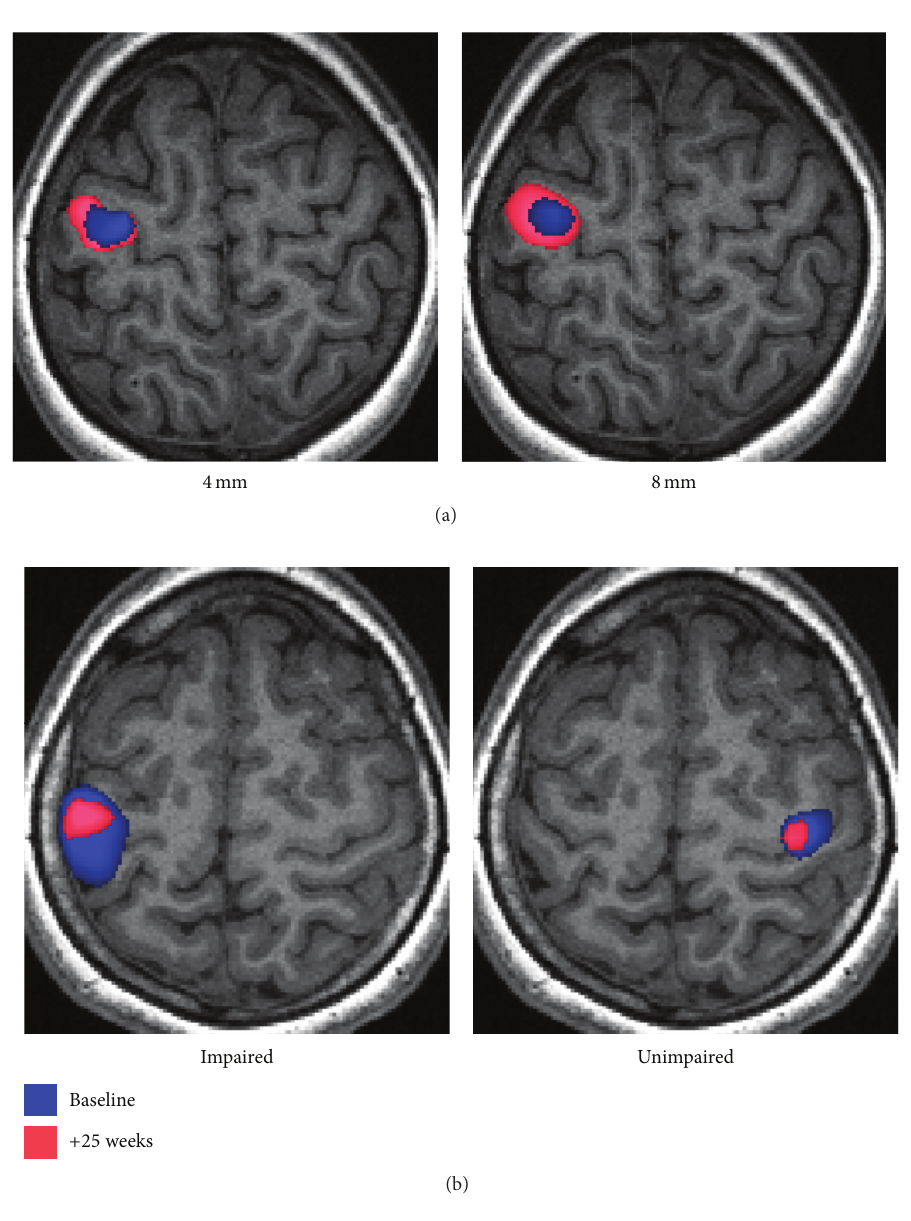
Figure 2: Voxel-wise fMRI analyses of a block-design hand-tapping task recorded at baseline (blue) and after ∼ 25 weeks (pink). (a) A subject with chronic traumatic brain injury who underwent virtual reality therapy during the 25-week period. In the affected hemisphere, the 25-week scan showed a 2.2 times or 3.3 times larger activation volume than the baseline scan, depending on whether a 4 mm (left) or 8mm (right) smoothing kernel was used. The 4 mm and 8 mm processing options were associated with peak voxel shifts of 8.6 mm and 5 mm, respectively. (b) A subject with cerebral palsy demonstrating large changes in activation between scans, for tapping of the impaired (left image) and unimpaired (right image) hands. The subject underwent no treatment during the 25-week period but was less anxious and followed the auditory cue marginally more accurately during the follow-up